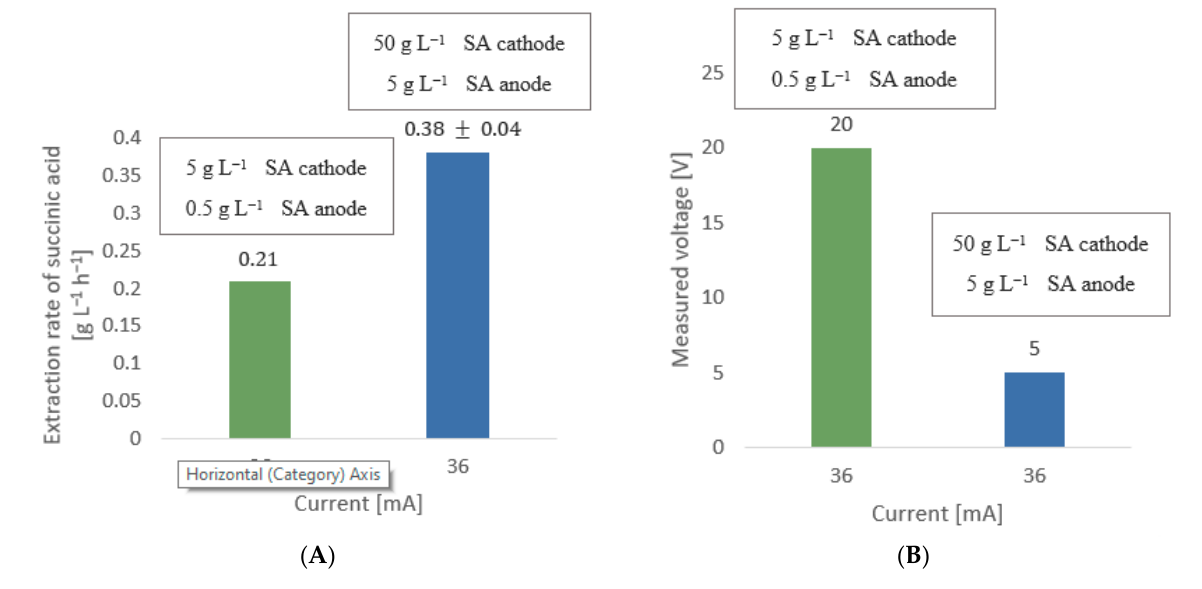
Figure 8. Two experiments are compared in terms of ( A ) extraction rate of succinic acid (SA) and ( B ) measured voltage as a function of initial concentration inside the electrolytic cell, both at a fixed current of 36 mA. The first experiment was performed with an initial concentration of 5 g L − 1 succinic acid in the cathode chamber and 0.5 g L − 1 of succinic acid in the anode chamber. This experiment was compared to a second experiment with 50 g L − 1 of succinic acid in the cathode chamber and 5 g L − 1 of succinic acid in the anode chamber. Note: SA = succinic acid.